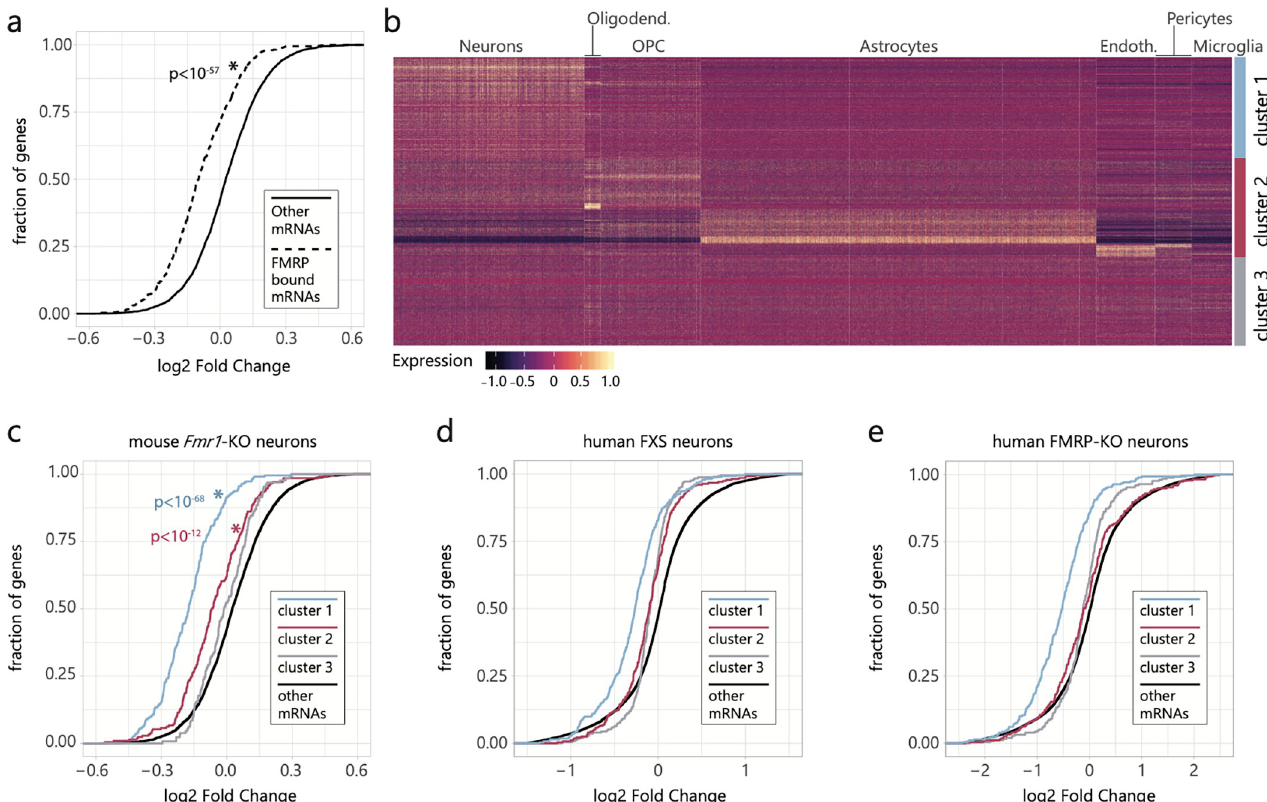
Fig 3. FMRP bound mRNAs show greater downregulation in neurons. a) Cumulative distribution plot of the log2 fold change between Fmr1 -KO and WT gene expression in neurons. Dashed lines represent mRNAs annotated as FMRP bound by Darnell et al. expressed in that cell type. Full lines represent all other expressed genes in that cell type. b) Heatmap of expressed FMRP bound mRNAs in WT cortex cells. Genes were clustered based on their expression pattern across cell types and resulting clusters comprise genes expressed at higher levels in neurons (cluster 1), non-neuronal cell types (cluster 2) and without cell type specificity (cluster 3). c) Cumulative distribution plot of the log2 fold change between Fmr1 -KO and WT gene expression in neurons. Colored lines represent each specific subset of expressed genes: Neuron FMRP bound mRNAs, which show highest expression in neurons (blue, cluster 1, Fig 3B); Non-neuronal FMRP bound mRNAs, which show highest expression in other cell types (pink, cluster 2, Fig 3B); Non-specific FMRP bound mRNAs (grey, cluster 3, Fig 3B), which are expressed at similar levels by all cortical cell types; and all other mRNAs expressed in neurons (black). d-e) Similar to (c) but displays the log2 fold change distribution for the homolog genes in each cluster of FMRP-bound mRNAs in human FXS neurons (d) or human FMRP-KO neurons (e). P-values refer to Wilcoxon rank-sum tests comparing the fold change distribution of each group of FMRP bound mRNAs to all other expressed mRNAs.